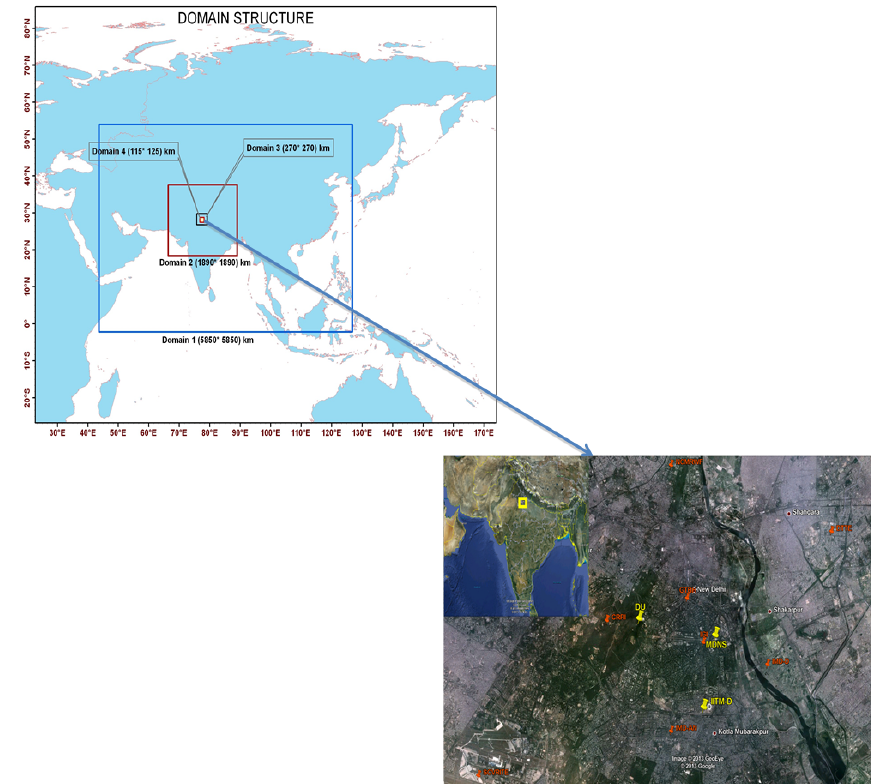
Figure 1. Nested model domains used in the Commonwealth Games forecasts and analysis. Insert shows the locations of the observations